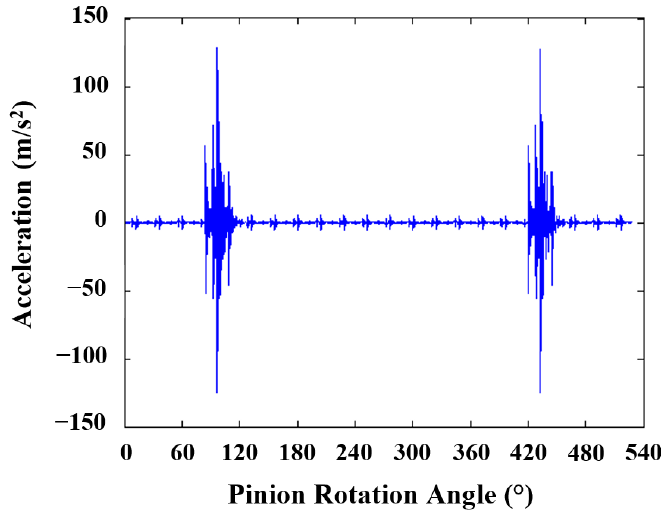
Figure 20. An example of residual signals acquired for the 20°/20° tooth pro fi le.